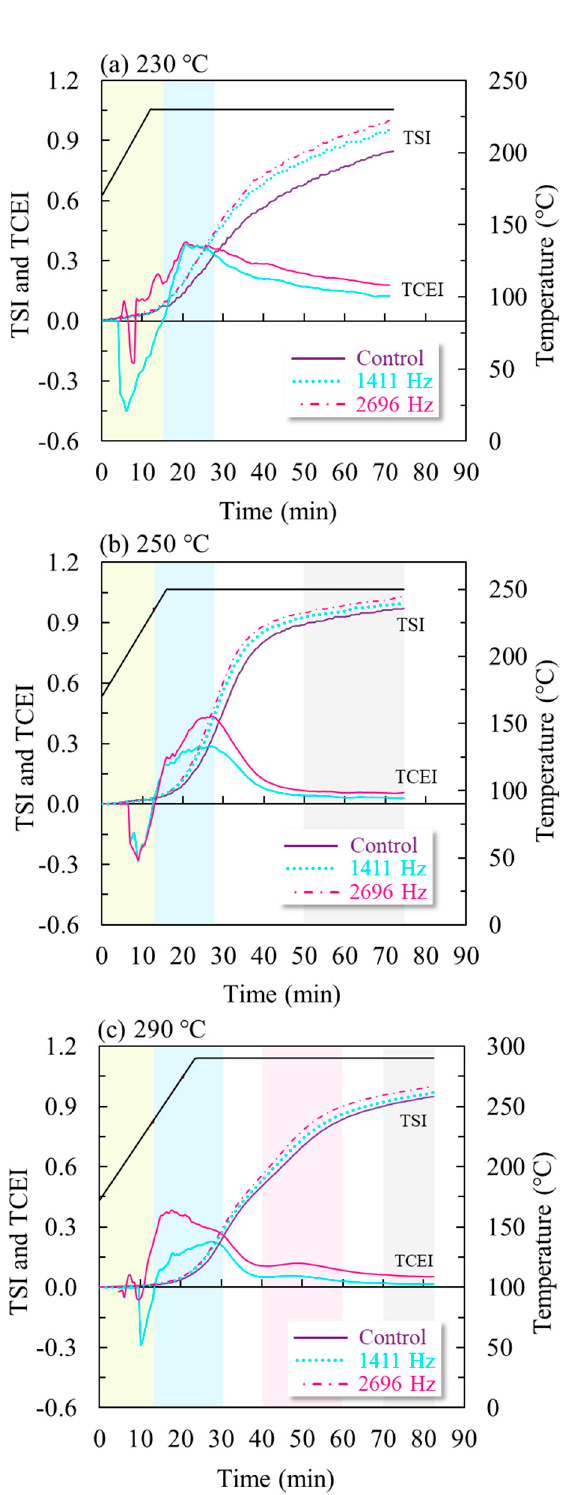
Figure 3. Torrefaction severity index (TSI) and torrefaction catalytic effect index (TCEI) profiles of thermoacoustic torrefaction for control, 1411, and 2696 Hz under ( a ) 230, ( b ) 250, and ( c ) 290 °C temperature treatments.